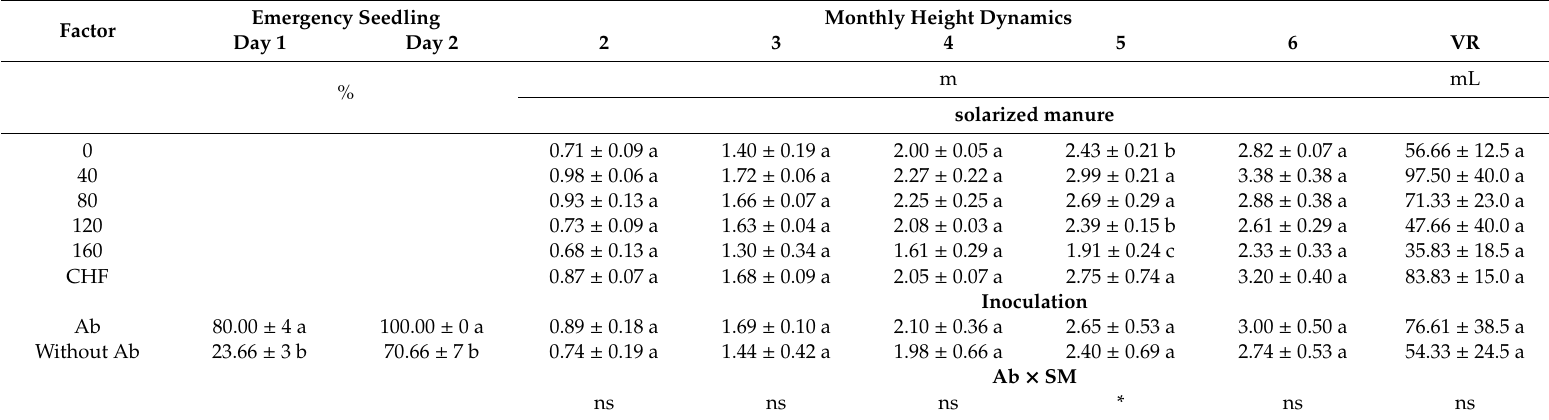
Table 3. E ff ect of Azospirillum brasilense (Ab), solarized manure and interaction (Ab × SM) on growth rate and root volume (VR) on tomato plants.